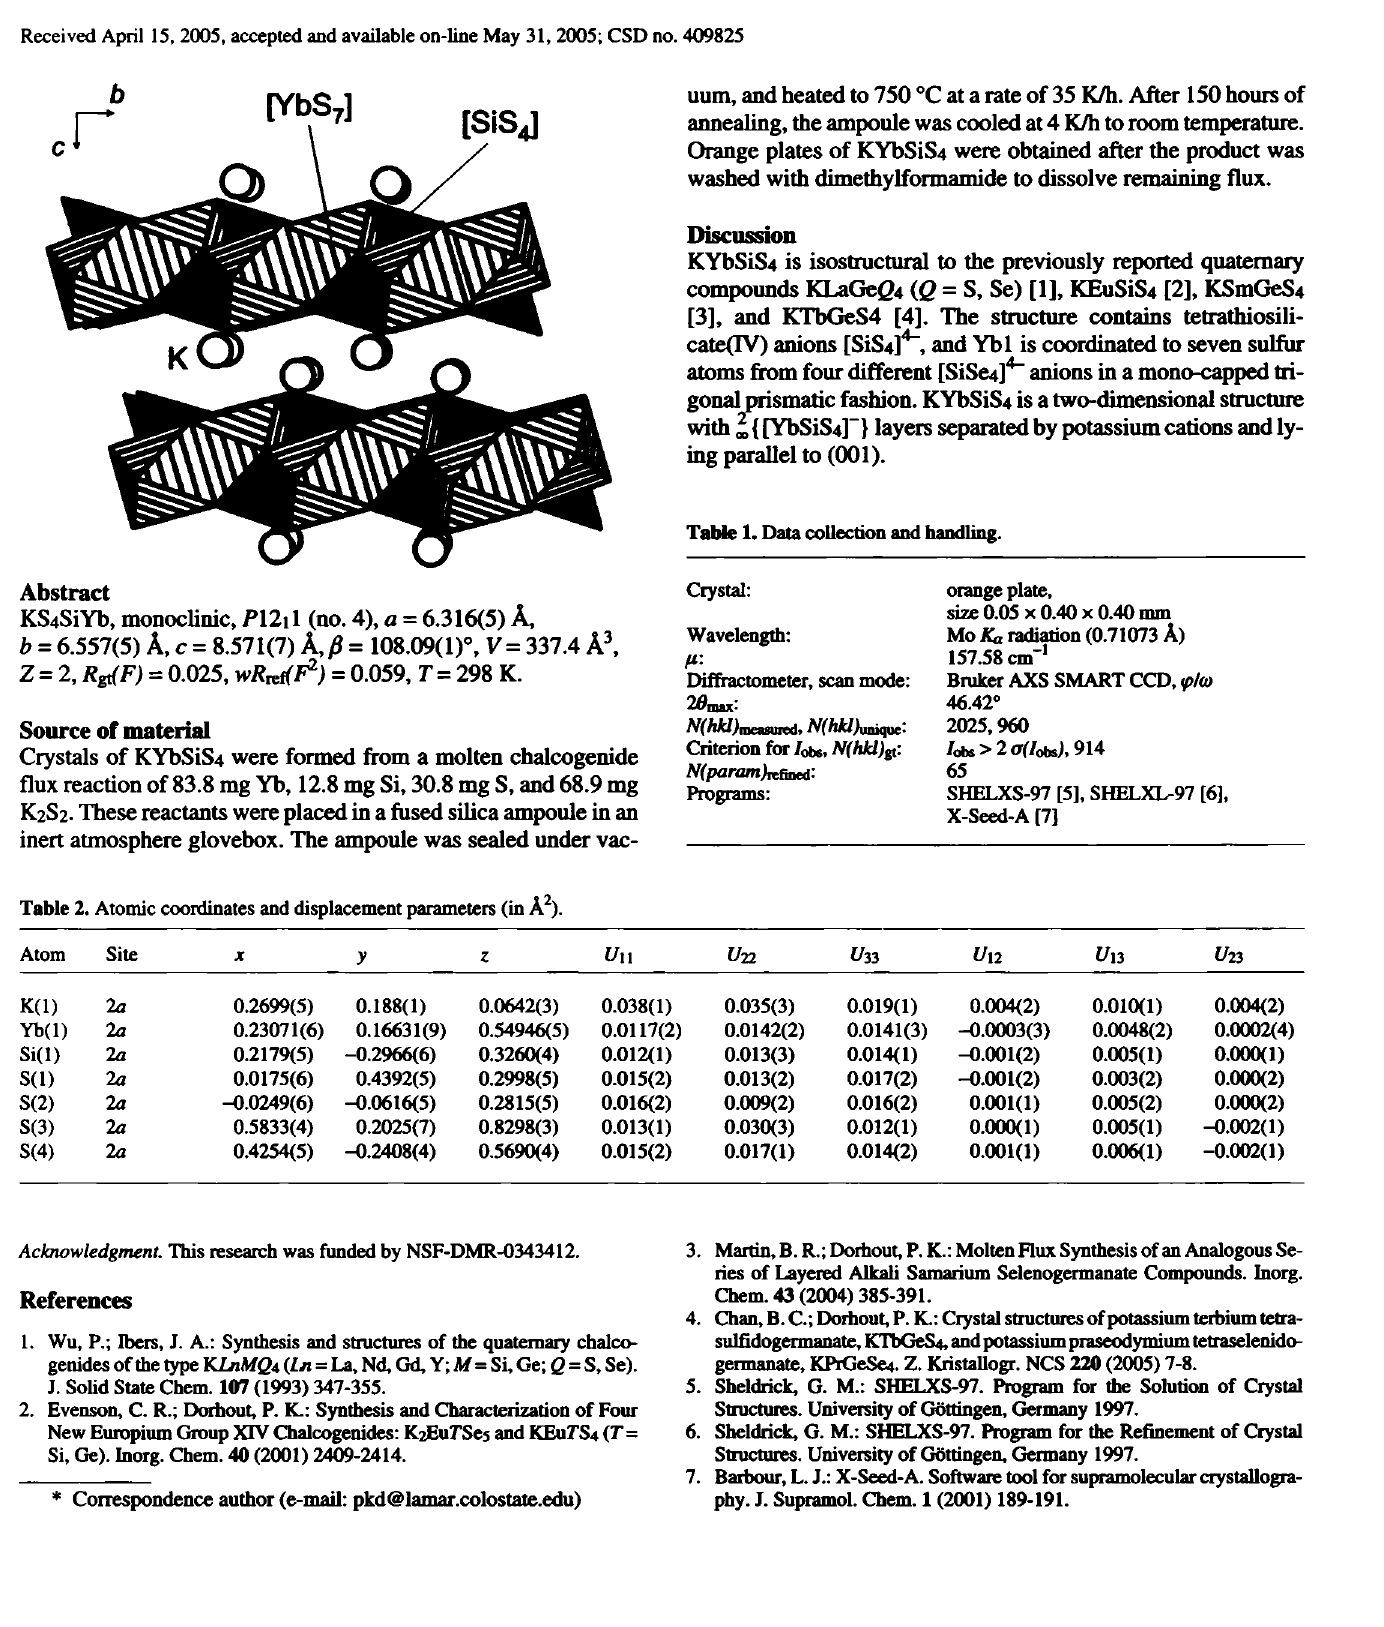
Table 1. Data collection and handling. Crystal: